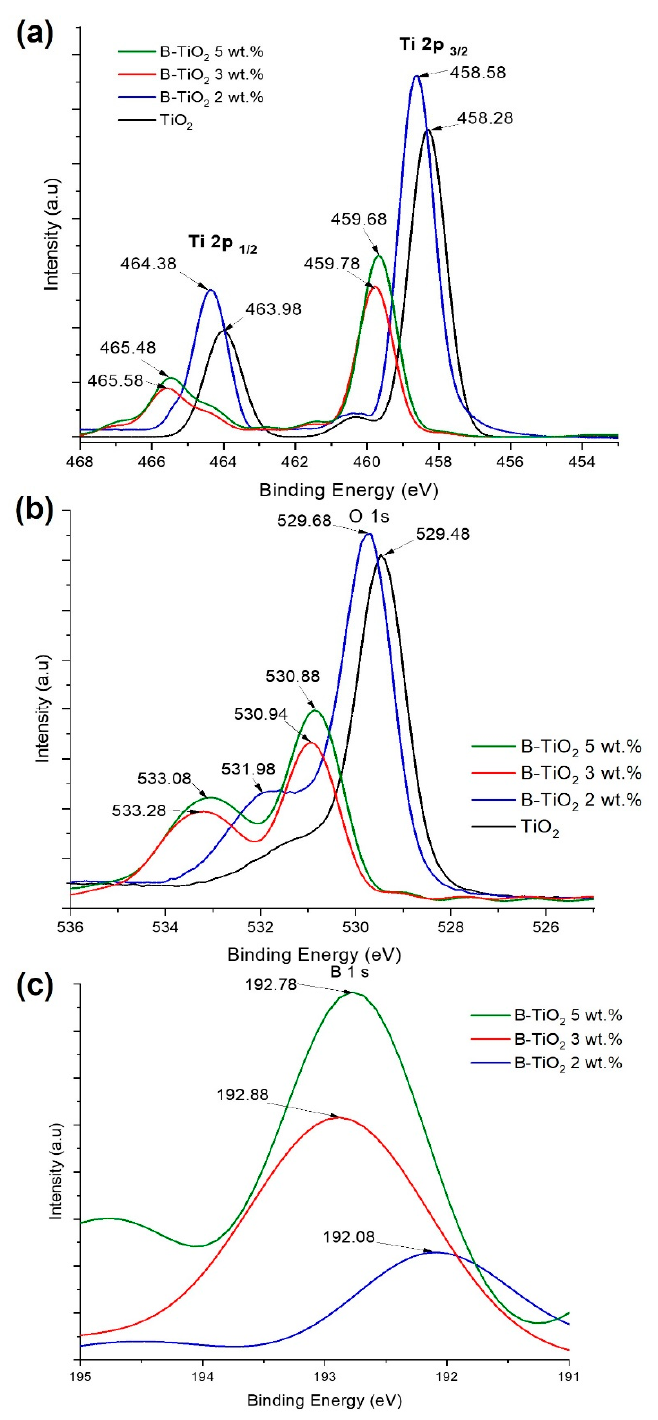
Figure 5. High-resolution XPS of ( a ) Ti 2p, ( b ) O 1s, and ( c ) B 1s for the B-doped catalysts.